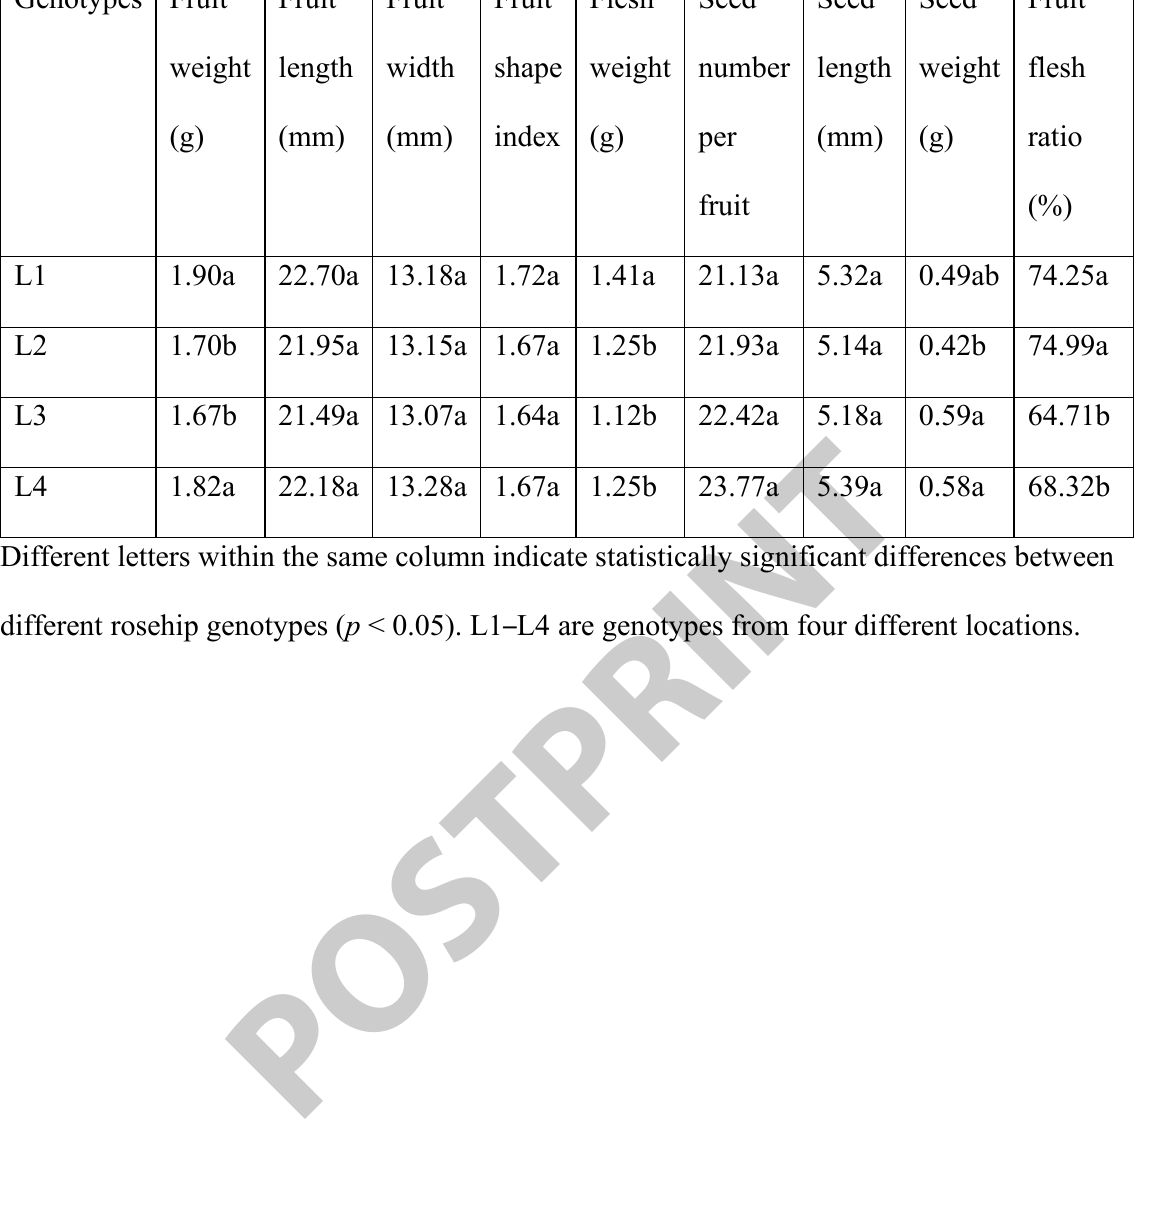
Table 1. Morphological and pomological characteristic of genotypes of rosehip fruits